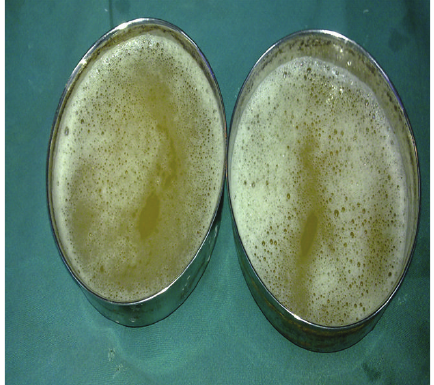
Figure 3: Serous fluid aspirated from the